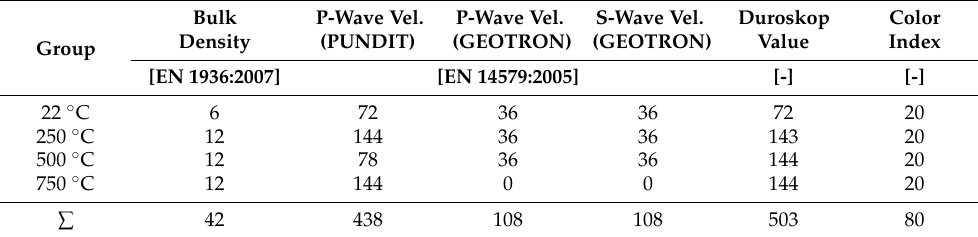
Table 1. Carried out measurements with test numbers and used standards.